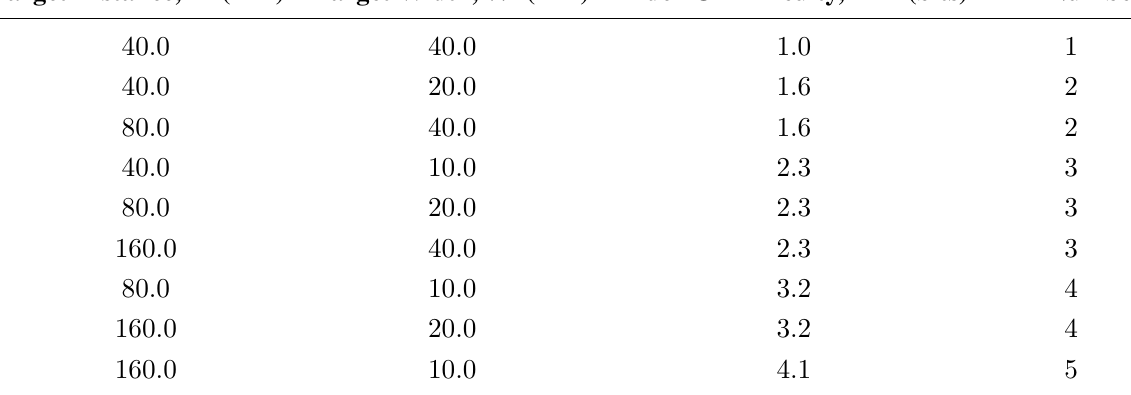
Table 1. Target conditions.